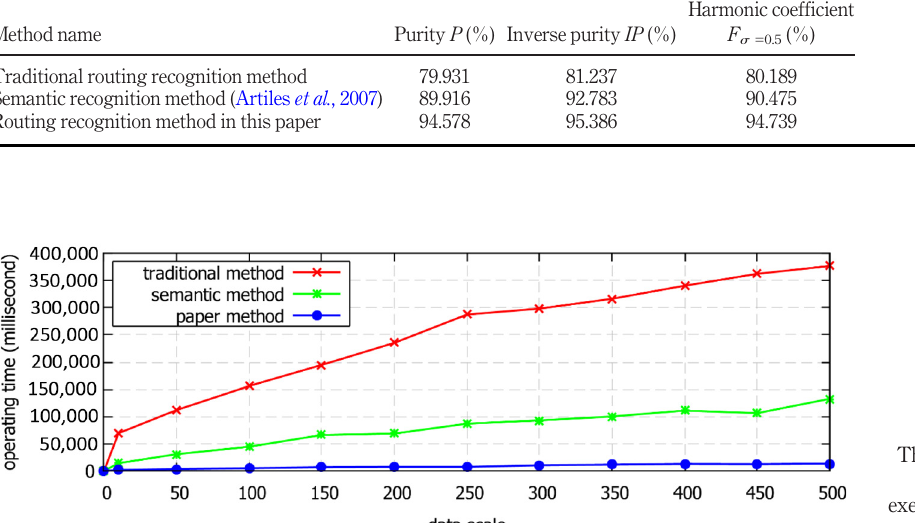
Figure 9. The comparison